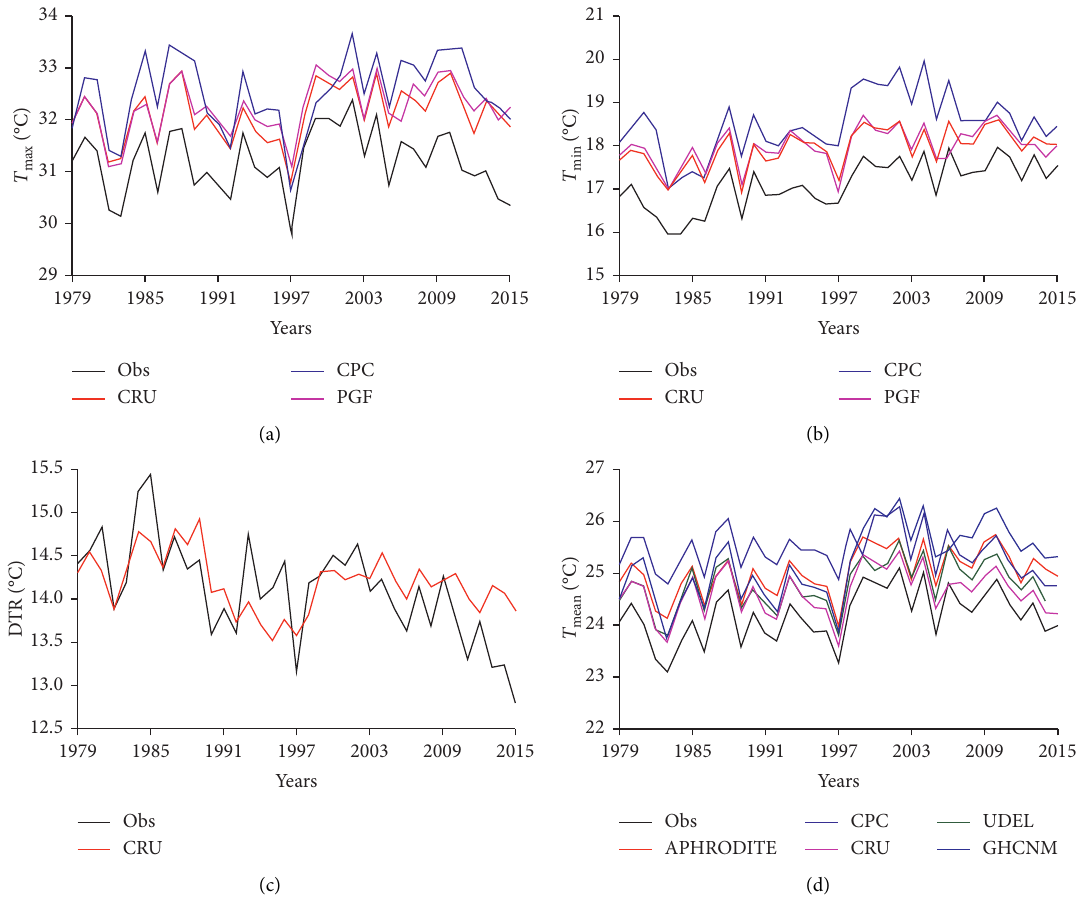
Figure 3: Temporal comparison of observation data and GDPs for (a) T